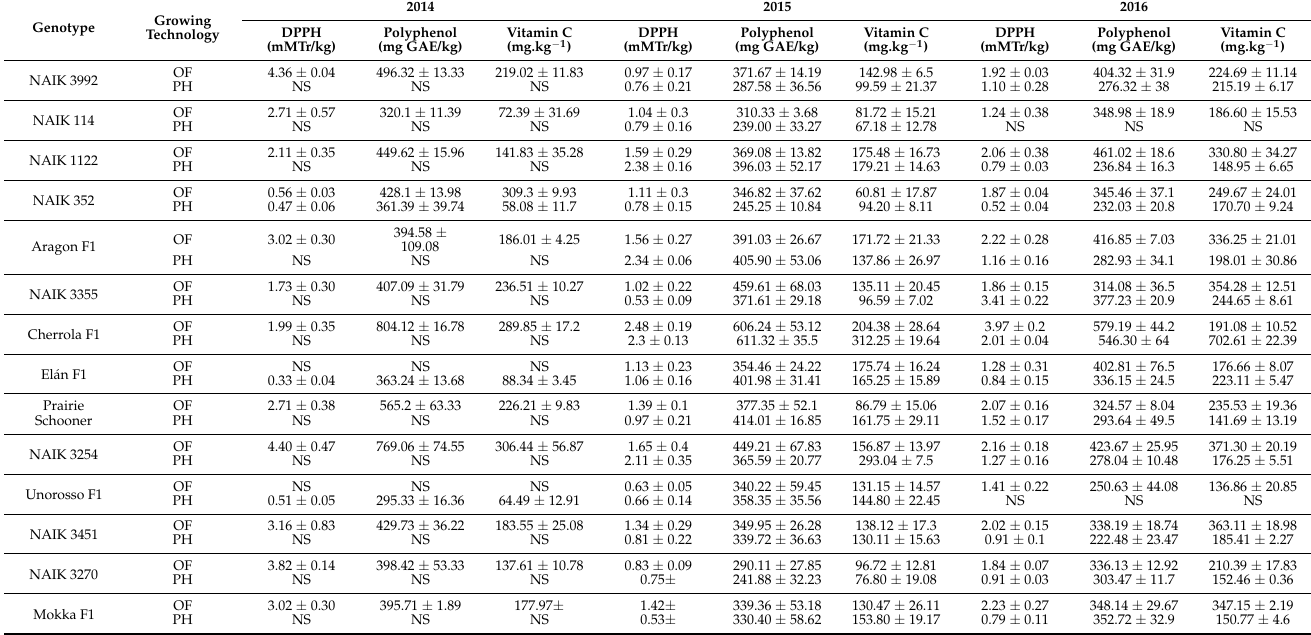
Table 3. Antioxidant capacity (DPPH), polyphenol, and vitamin C concentrations in tomato sam- ples during 2014–2016 under different growing technology (NS—no samples; OF—open field; PH—plastic